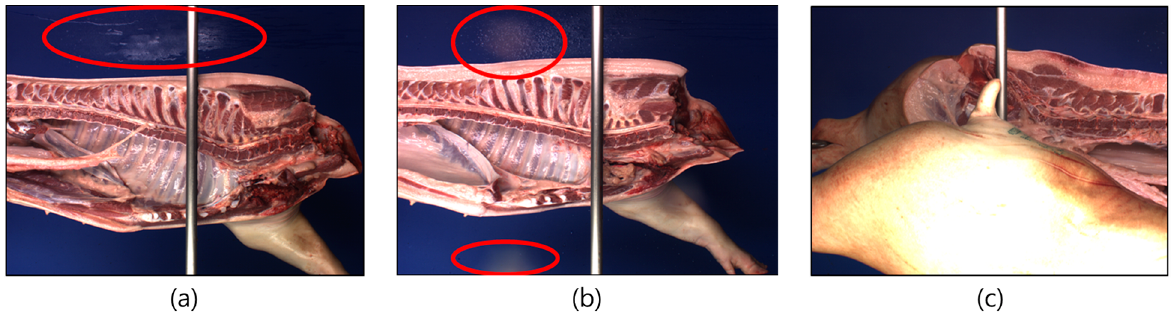
Figure 11. Artifact generated during image acquisition by automated pork carcass processing systems. ( a ) Image Artifact 1: blue screen spottedness (red circle location), ( b ) Image Artifact 2: an after-image (red circle location), ( c ) Image Artifact 3: an overlapped carcass image.